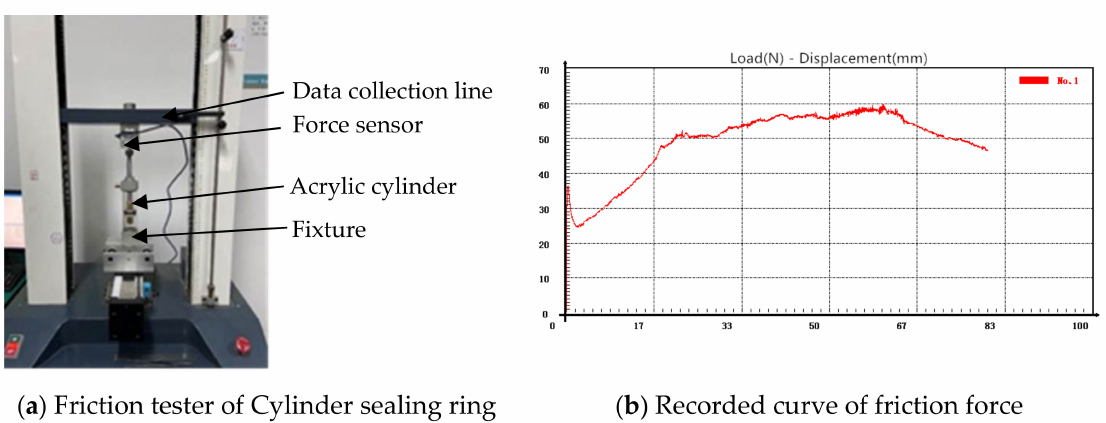
Figure 1. Principles of friction force testing for cylinder sealing ring.